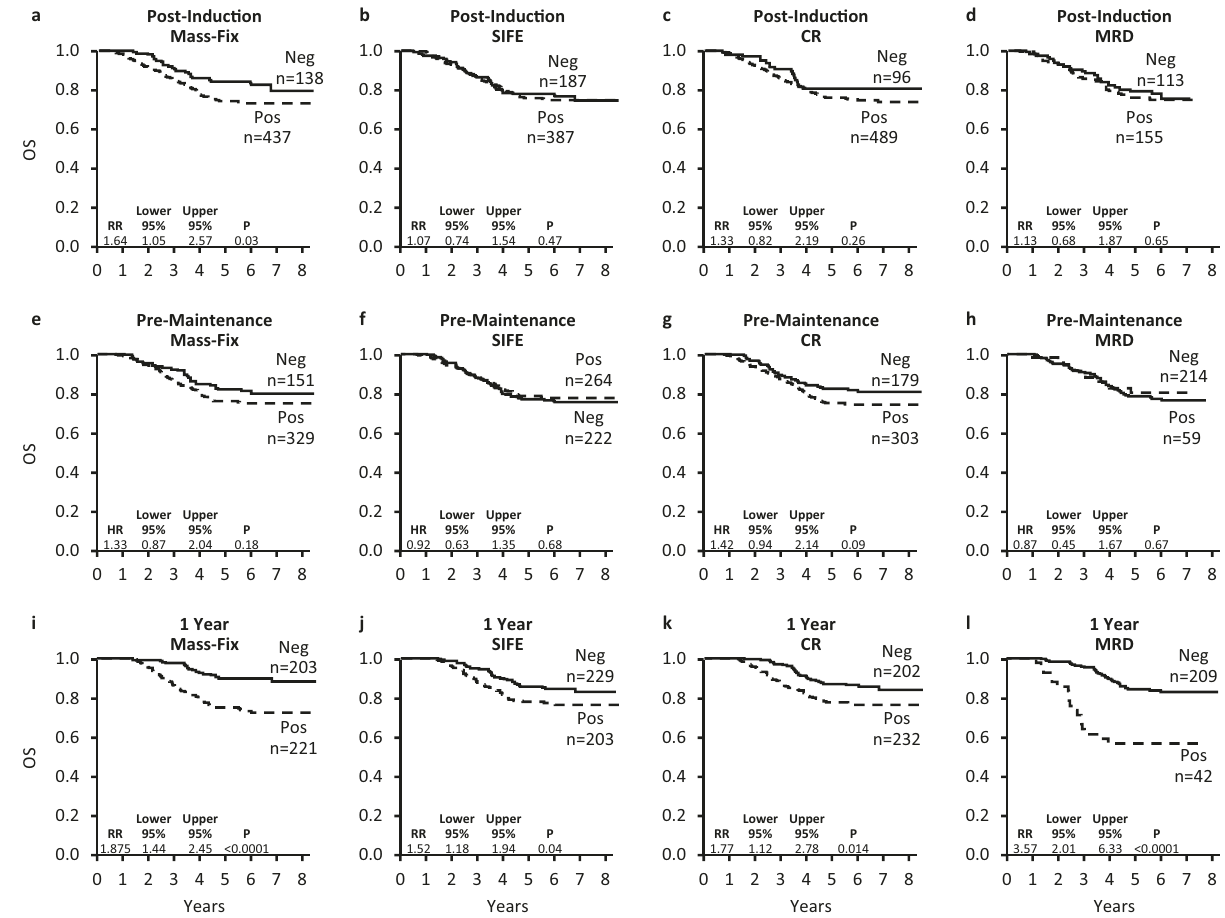
Fig. 4 Overall survival based on response measurement at speci fi c time points. a – d Post-induction sample; d – h pre-maintenance sample; and i – l 1 year post enrollment